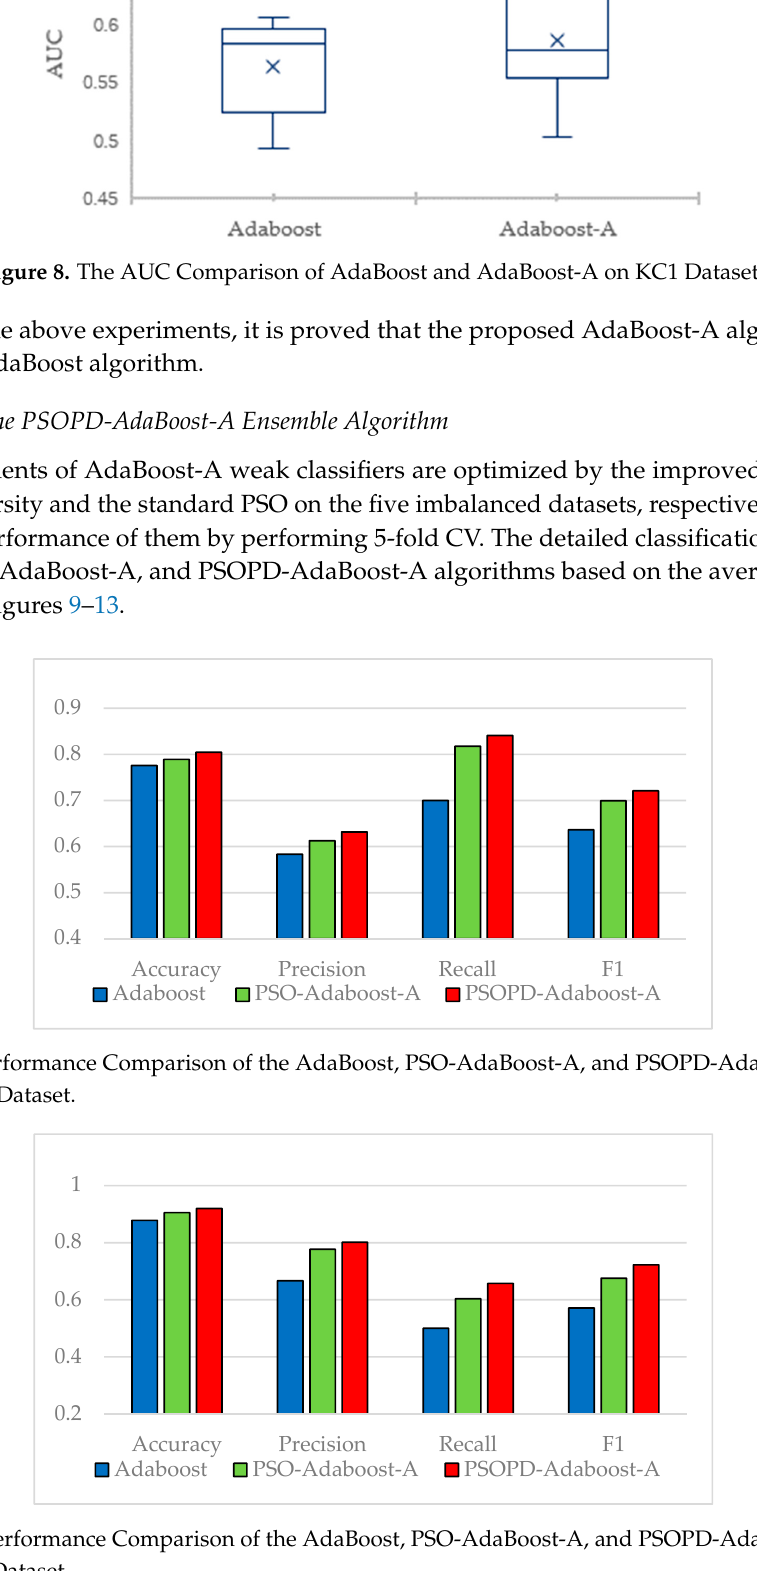
Figure 7. Error Comparison of AdaBoost and AdaBoost-A on KC1 Dataset.